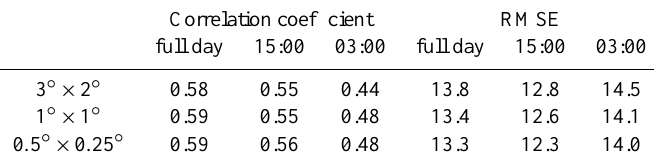
Table B1. Average temporal correlation coefficient and RMSE (ppbv) for June 2006 compared to EMEP data at the station locations shown in Fig. B2 as a function of horizontal resolution, taking data for the whole day or sampled only at 15:00 or 03:00UTC. Correlation coefficient